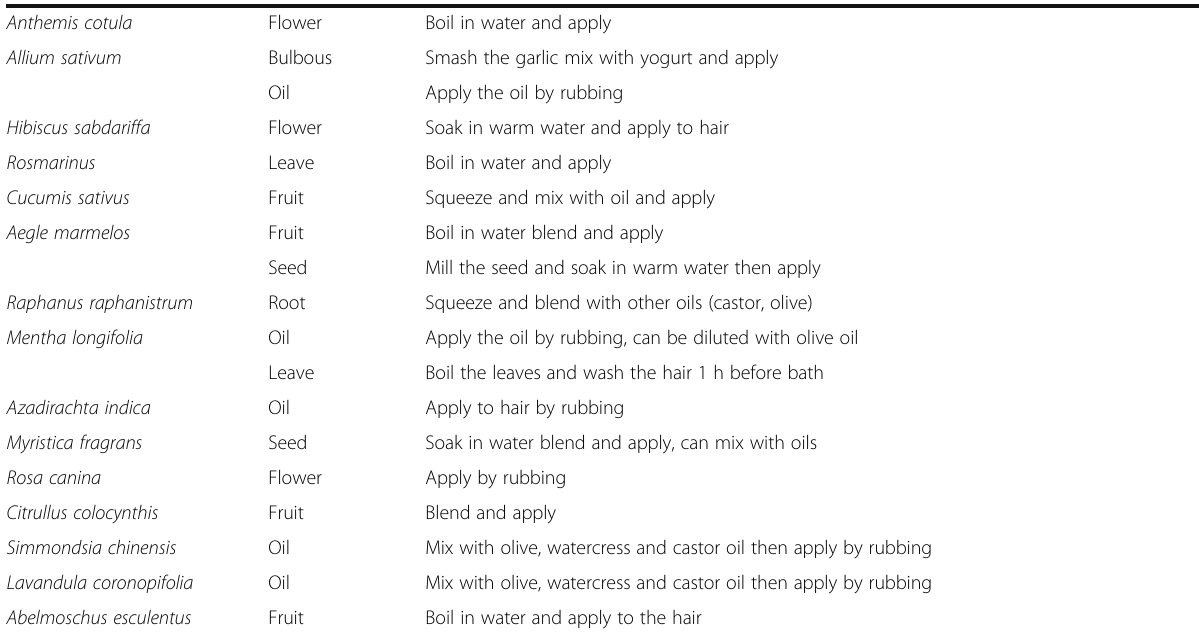
Table 6 Plant products, parts used and preparation methods (Continued)